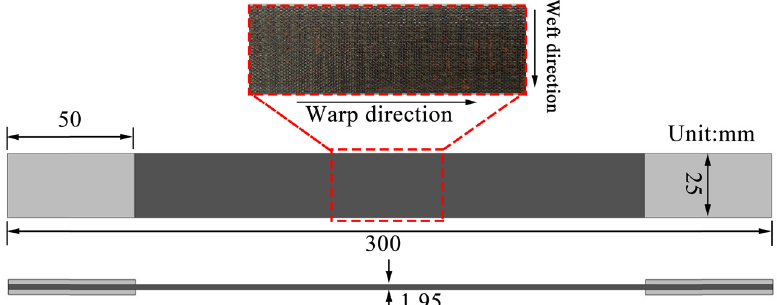
Figure 4: The speci fi c geometric dimensions of the specimen.